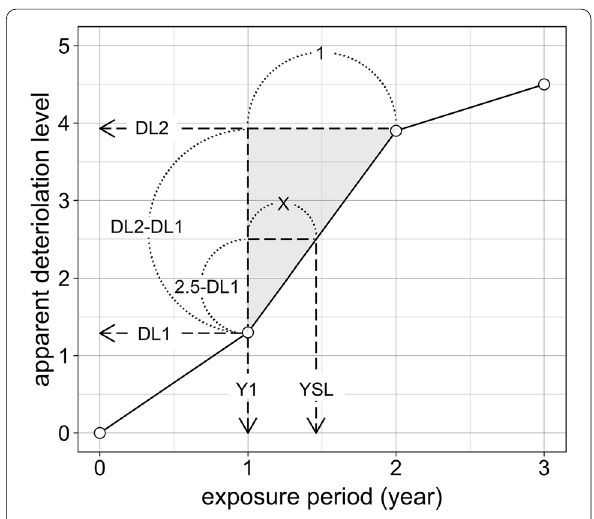
Fig. 1 Methodology for service life calculation